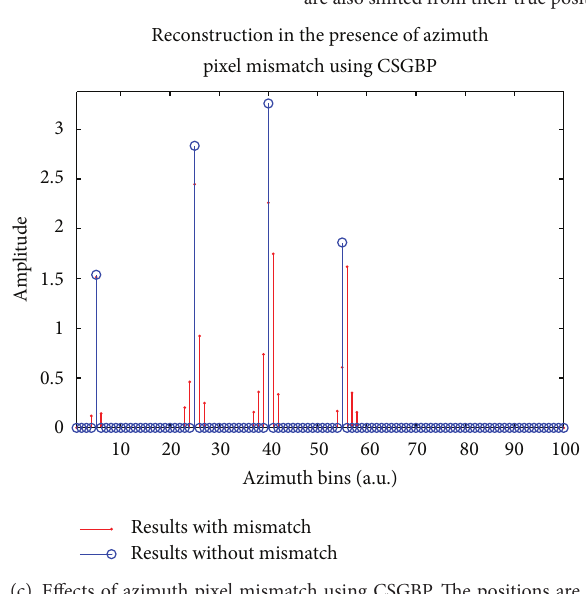
Figure 5: Effects of azimuth pixel mismatch using CSLP and